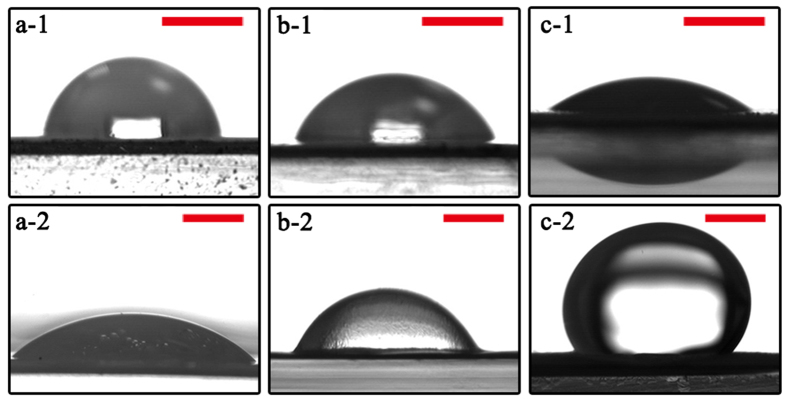
The surface wettability of membrane.(a) P membrane, (b) GO-P membrane, (c) GO-P-S membrane. (a-1~c-1) Water contact angles in air, scale bar, 1 mm. (a-2~d-2) Underwater oil contact angles, scale bar, 1 mm.